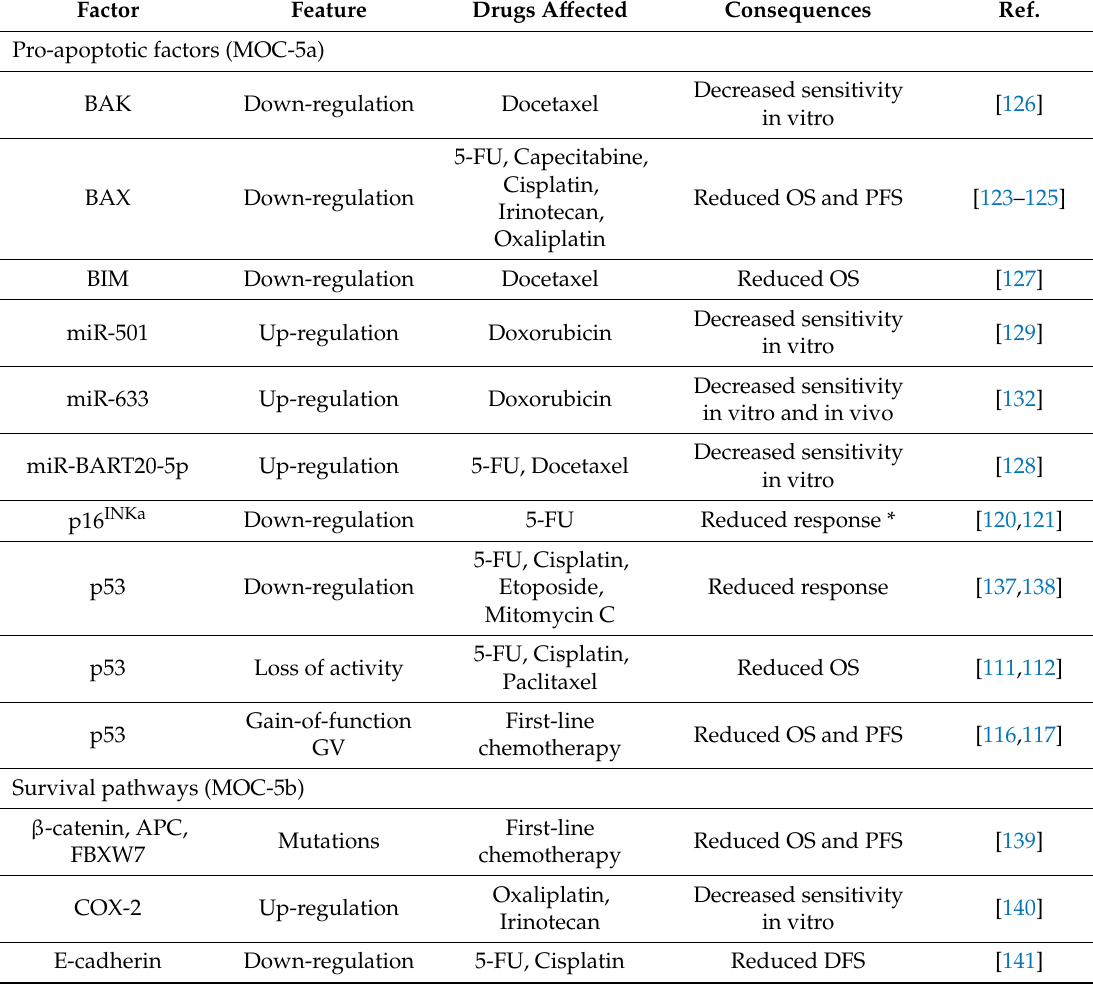
Table 5. Mechanisms of chemoresistance type 5 (MOC-5) to drugs used in the treatment of GAC. Factor Feature Drugs A ff ected Consequences